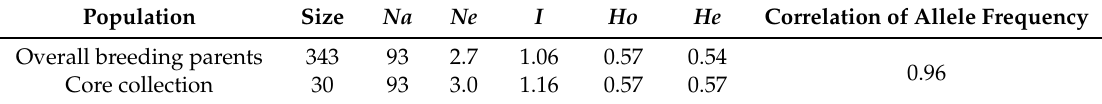
Figure 5. Pairwise linkage disequilibrium (LD) ( R 2 ) between simple sequence repeats (SSRs) in cypress.